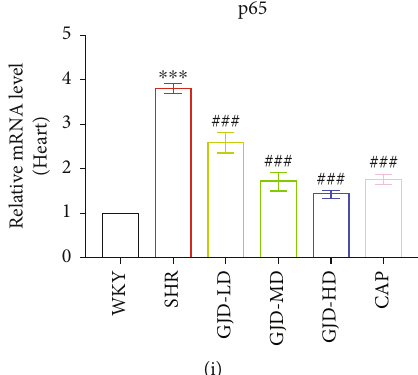
Figure 4: E ff ects of GJD on mRNA expression of interleukin -1 beta, interleukin-6, TNF-alpha, type I collagen, type III collagen, and alpha- SMA in the left ventricular. (a) Interleukin-1 beta, (b) interleukin-6, (c) TNF-alpha, (d) type I collagen, (e) type III collagen, (f) alpha-SMA, (g) TAK1, (h) IkB-alpha, and (i) p65. WKY indicates the WKY control group, SHR indicates the SHR model group, GJD-LD indicates the SHR treated with GJD at a low dose, GJD-MD indicates the SHR treated with GJD at a medium dose, GJD-HD indicates the SHR treated with GJD at a high dose, and CAP indicates SHR treated with captopril. Data are means ± SD , n = 3 . ∗ P < 0 : 05 , ∗∗ P < 0 : 01 , ∗∗∗ P < 0 : 001 vs. WKY group, # P < 0 : 05 , ## P < 0 : 01 , ### P < 0 : 001 vs. SHR